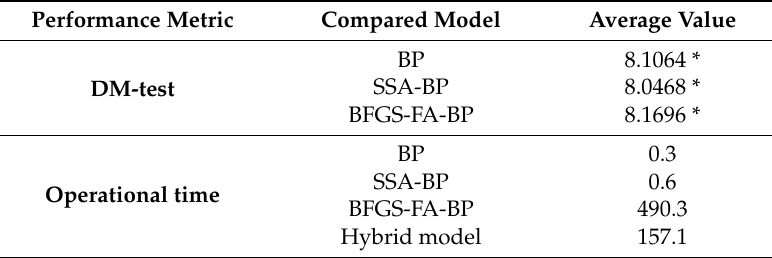
Table 12. Results of the DM test and operational time